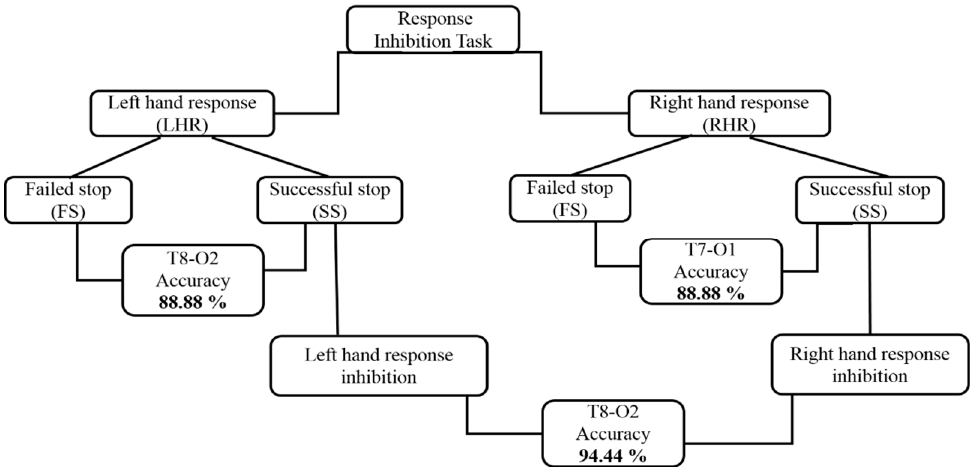
Figure 6. The structure of hierarchical classification system during left-hand and right-hand response